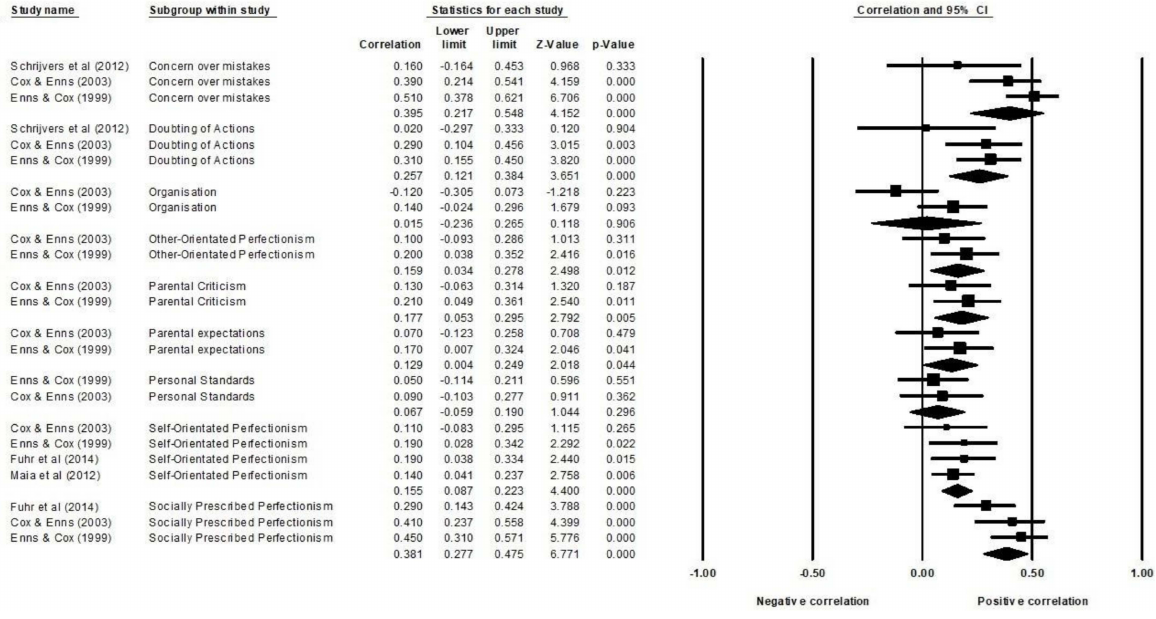
Figure 2. Forest plot of perfectionism subtypes and depression symptom severity